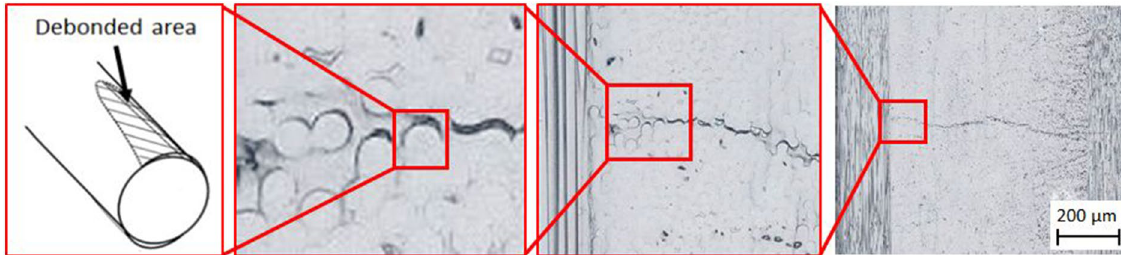
Figure 1. Magnified image of a transverse crack in a cross-ply laminate implying the initiation of interfacial debonding between the carbon fiber and epoxy matrix. The transverse crack resulted from the propagation of the matrix cracking, which was caused by connecting the interfacial debonding of neighboring carbon